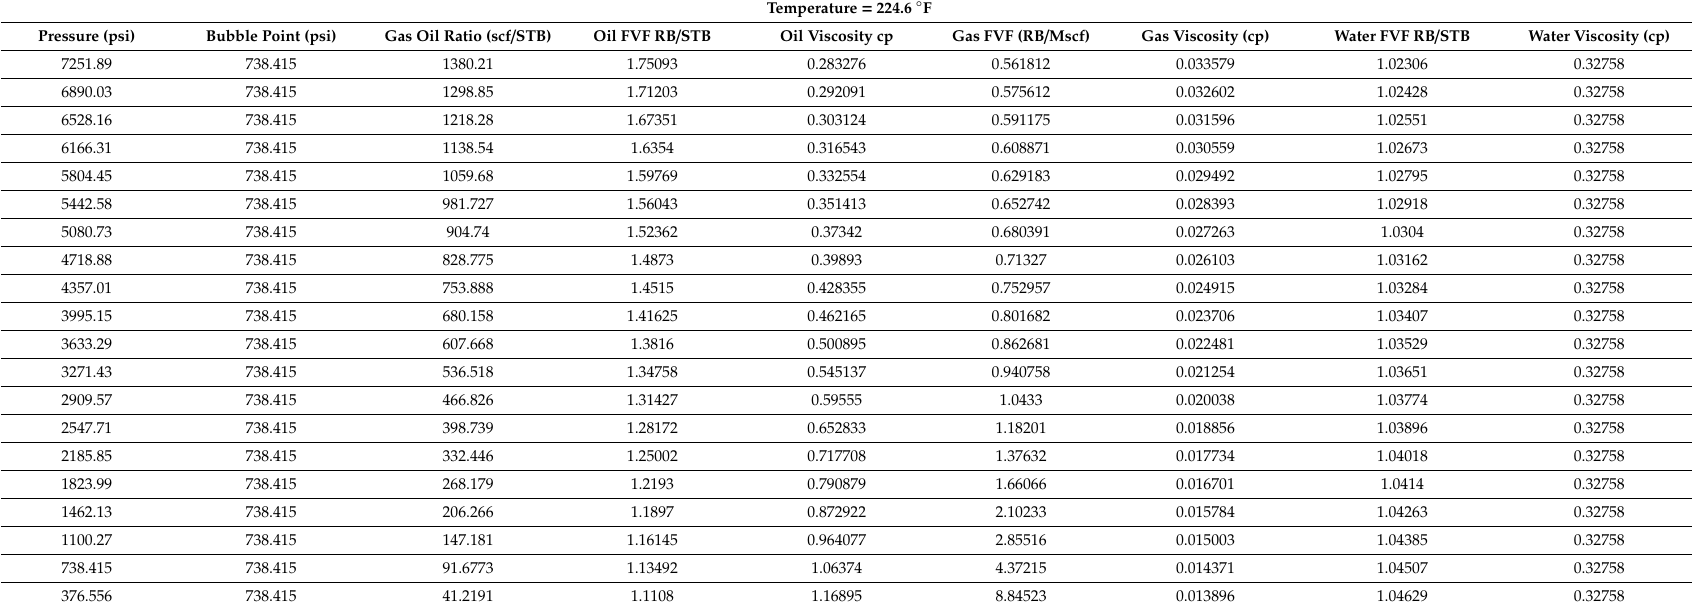
Table A1. Isothermal Fluid PVT